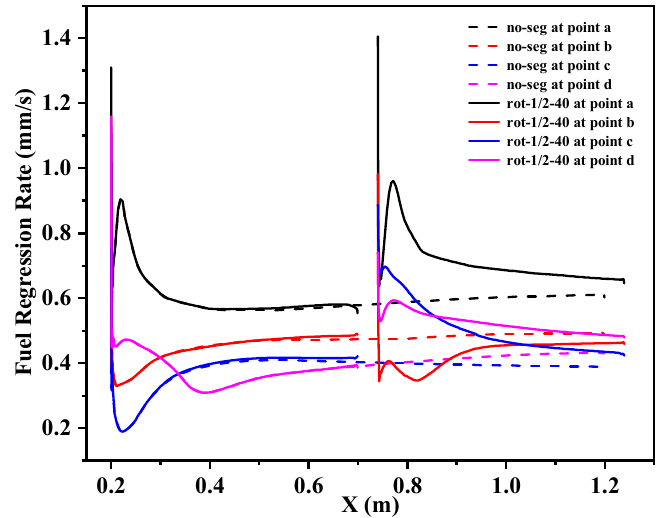
Figure 21. Regression rates at various positions along the motor axis.